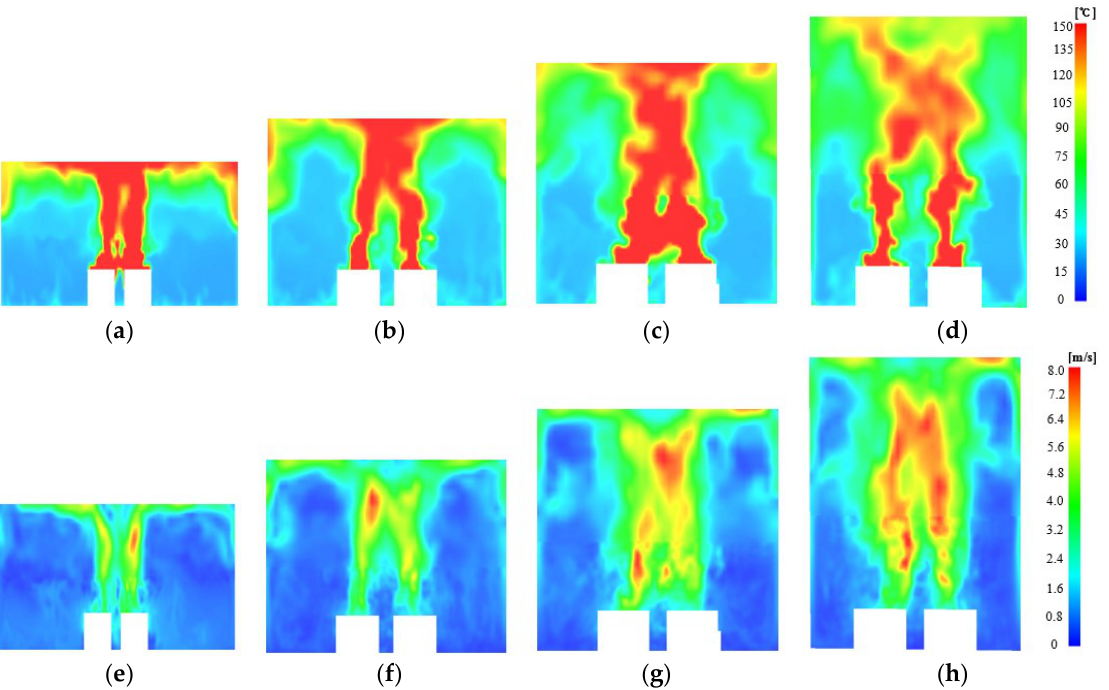
Figure 4. Temperature and smoke velocity contours at 1500 s; ( a – d ) represents the temperature distribution where the tunnel aspect ratio is 0.36, 0.72, 1 and 1.39, respectively, ( e – h ) represents the smoke velocities.